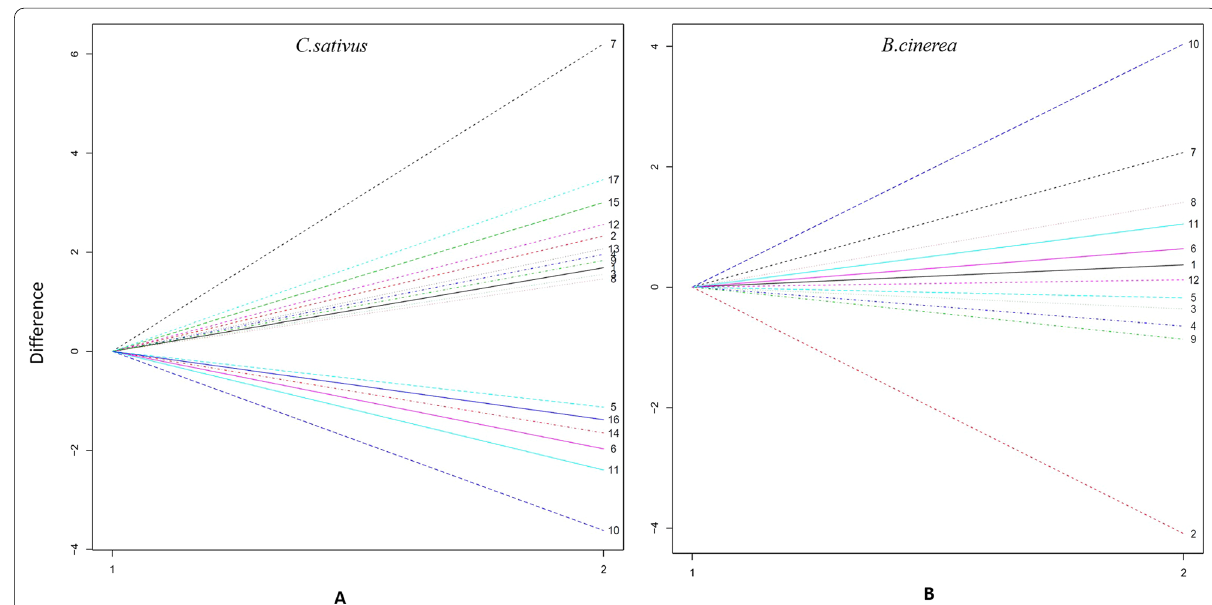
Fig. 3 Relative differences among gene expression curves of different groups expressed in A C. sativus and B B. cinerea